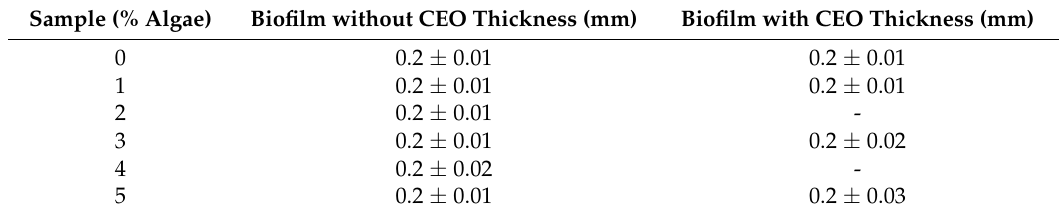
Table 1. Thickness of algae-based film with and without